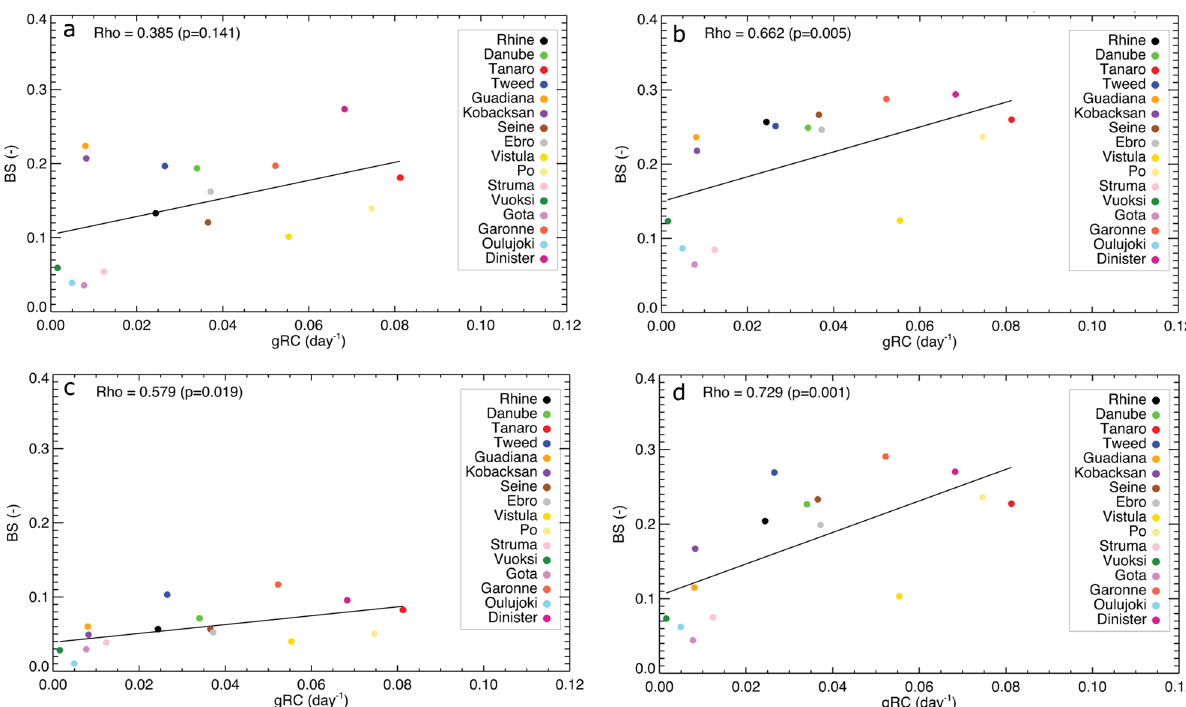
Figure 4. Correlation between BS and gRC for the 16 selected river catchments: ( a ) for SSI-1 LT = 1, ( b ) for SSI-1 LT = 3, ( c ) for SSI-3 LT = 1, and ( d ) for SSI-3 LT =